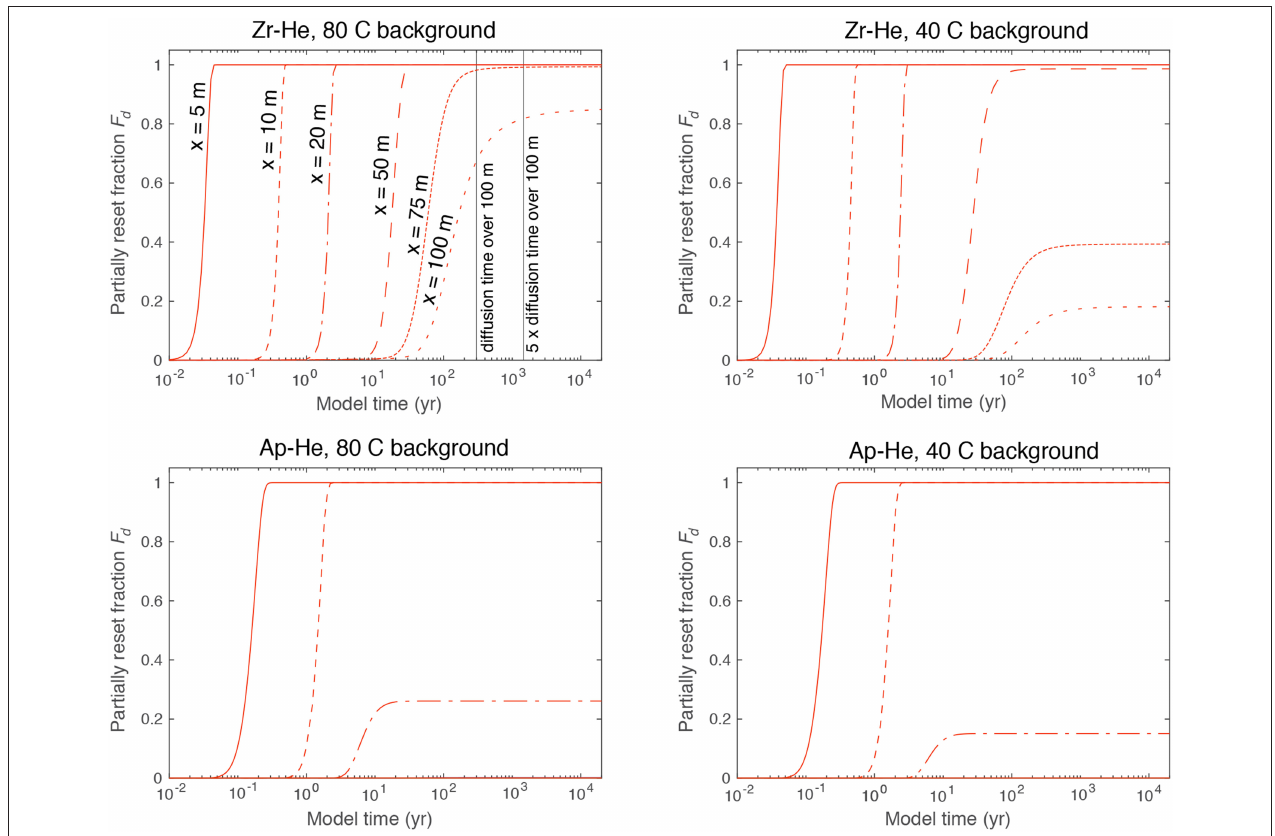
FIGURE 7 | Relationship between partial resetting of apatite and zircon He thermochronometers as a function of heating and hold time (kinetics of thermal vs. chemical diffusion), with the same parameters as Figure 6 and two background temperatures T BG . Curves on each panel represent listed distances x from the dike center, as in Figure 6 . Vertical lines in upper left panel correspond to multiples of a thermal diffusion time over 100 m (100 2 ρ c p / k ).